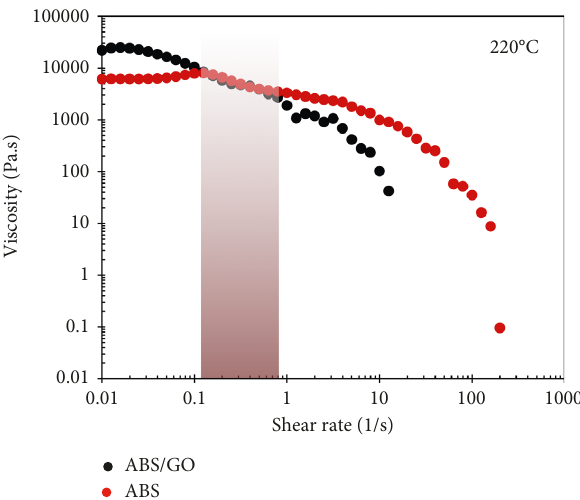
Figure 7: Shear rate dependence of viscosity for ABS and ABS/GO composite